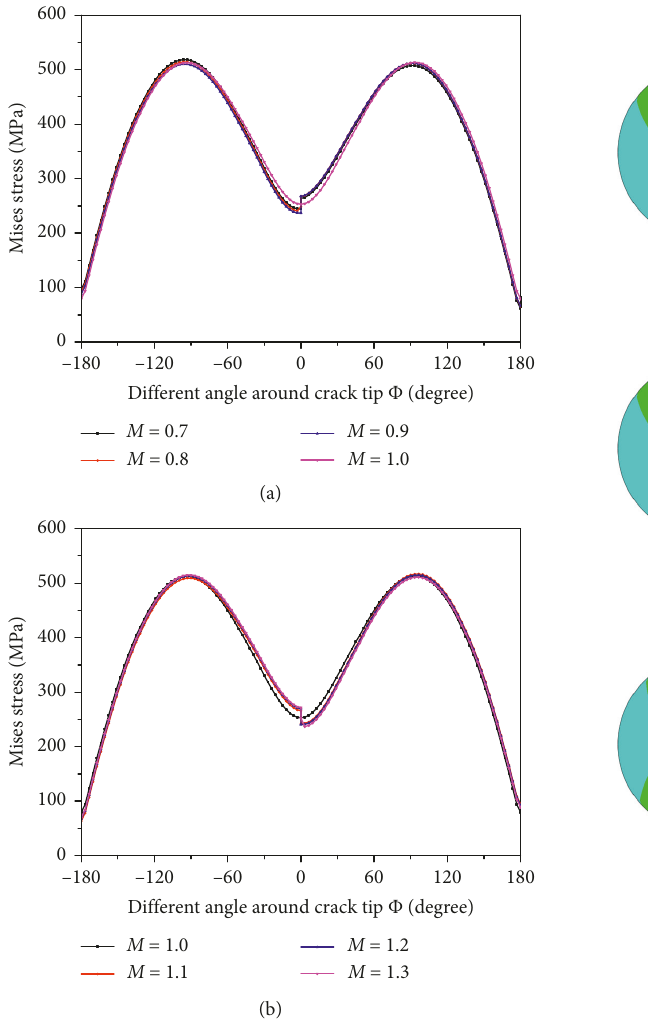
Figure 12: The Mises stress curve of “sandwich” material structure model around crack tip. (a) Mismatch coefficient M ≤ 1. (b) Mismatch coefficient M ≥ 1.